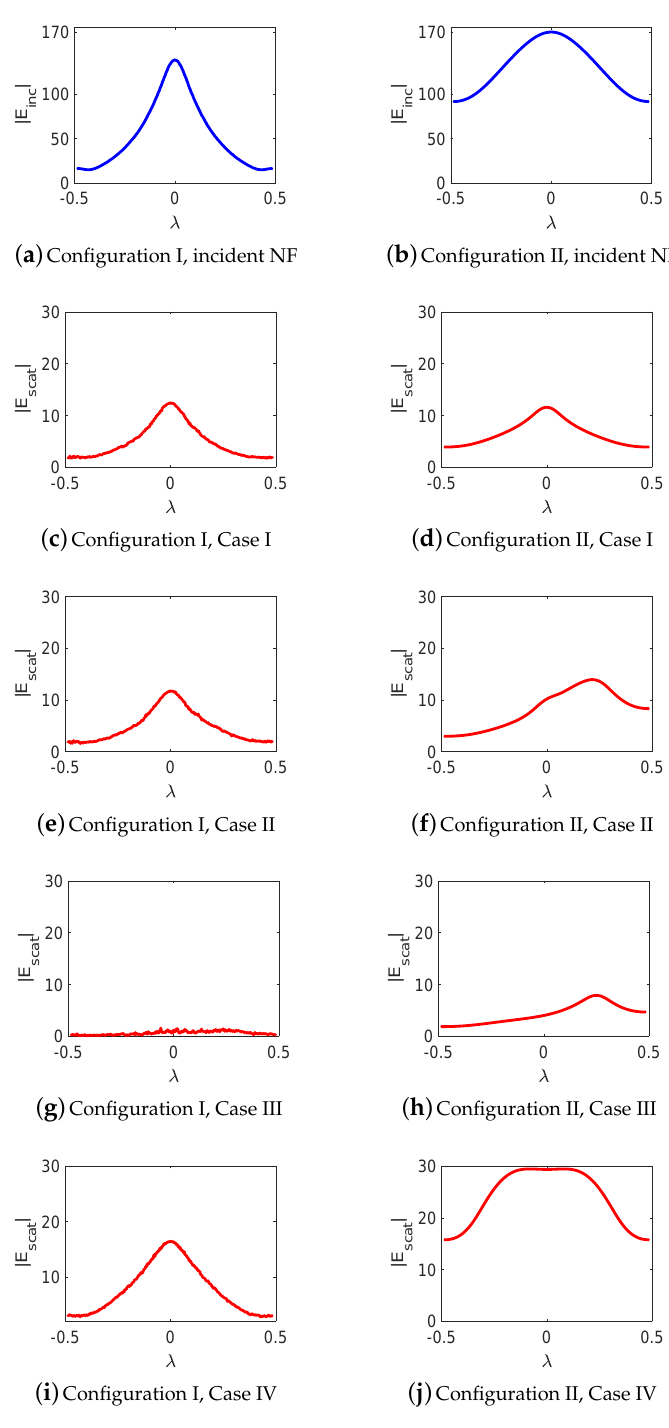
Figure 7. Configuration I represents the presence of the NF plate, and Configuration II represents its absence. ( a , b ) show the incident NF distributions at the receivers’ locations; ( c – j ) scattered NF data under the two configurations for Cases I to